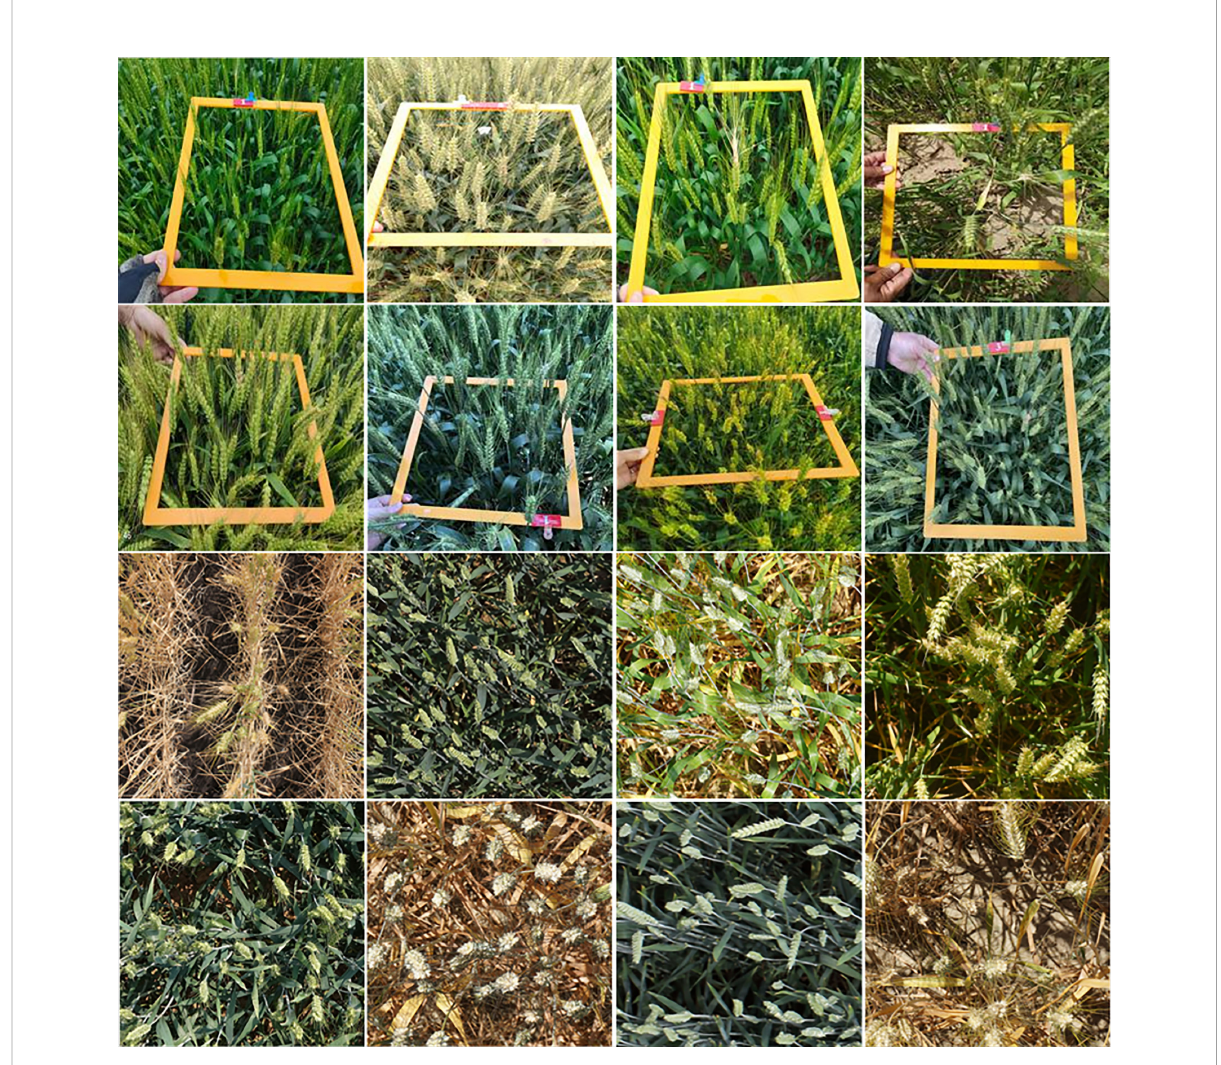
FIGURE 2 Samples of the WSD-2022 dataset. The fi rst and second rows of the fi gure show the images that we acquired, while the third and fourth rows of the fi gure come from